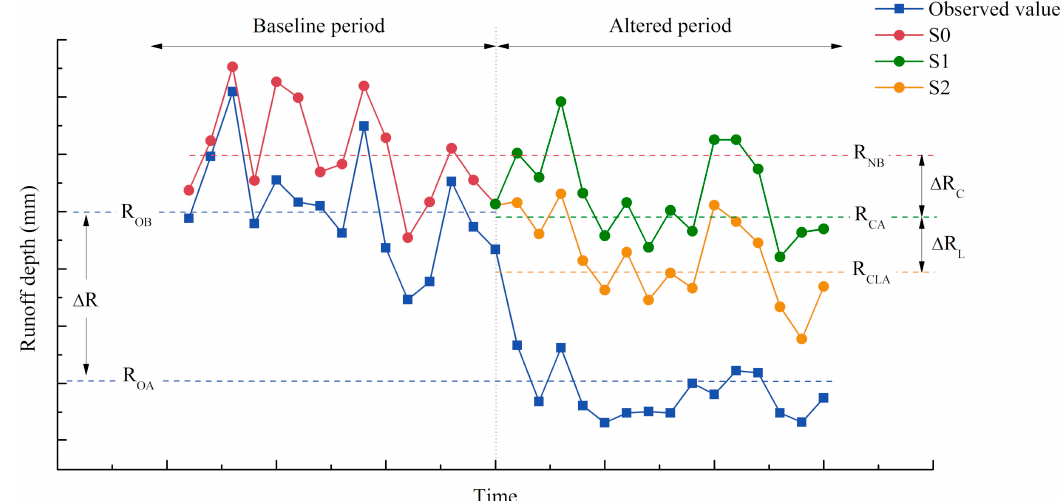
Figure 2. A diagrammatic plot of evaluating the effects of climate variation, land use change, and direct human intervention on runoff variation.